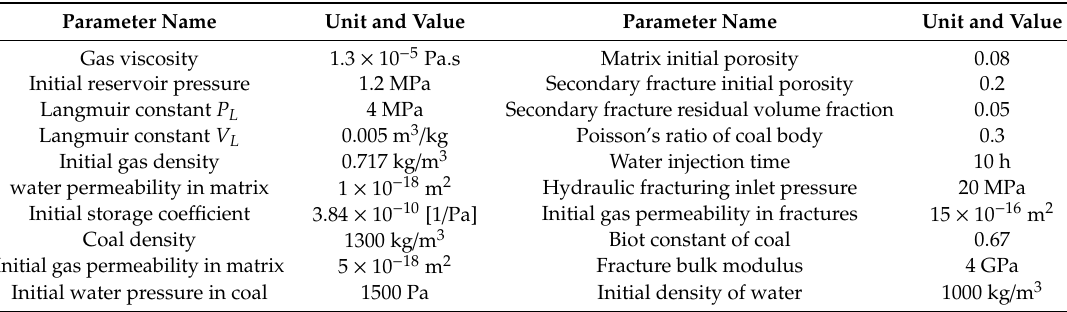
Table 1. Experimental parameters used in the